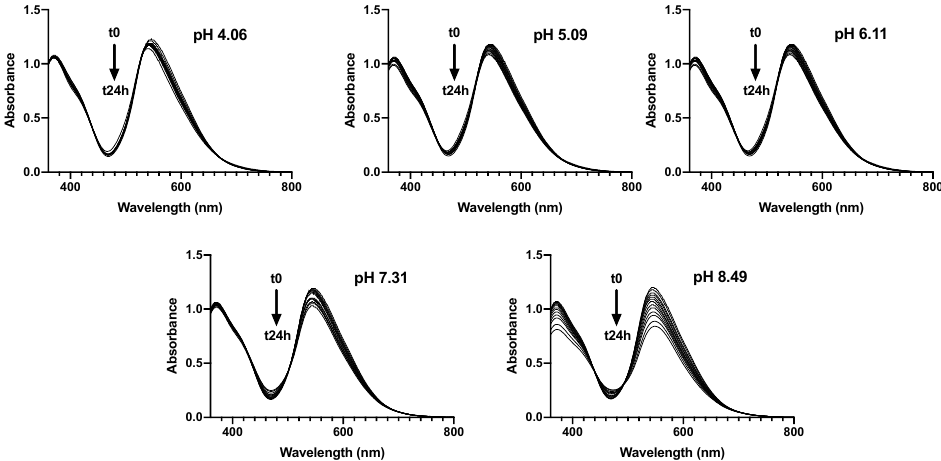
Figure 5. UV-Visible spectra of dye 1 (4-dimethylamino pyranoflavylium cinnamate ester) in aqueous solution with 50% ( v / v ) ethanol/water at different pH values from 4 to 8 over time. The spectra were recorded for 24 h at different pH values.